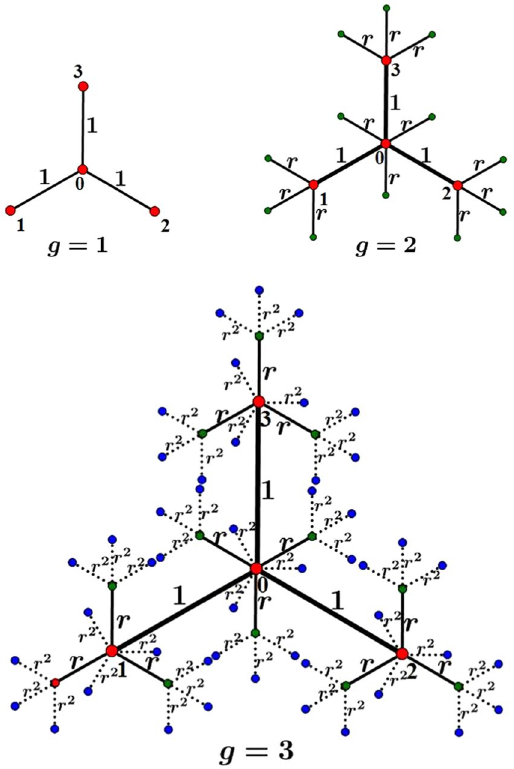
Figure 1. Iterative construction method for weighted polymer networks from g = 1 to g = 3 for the case of f =